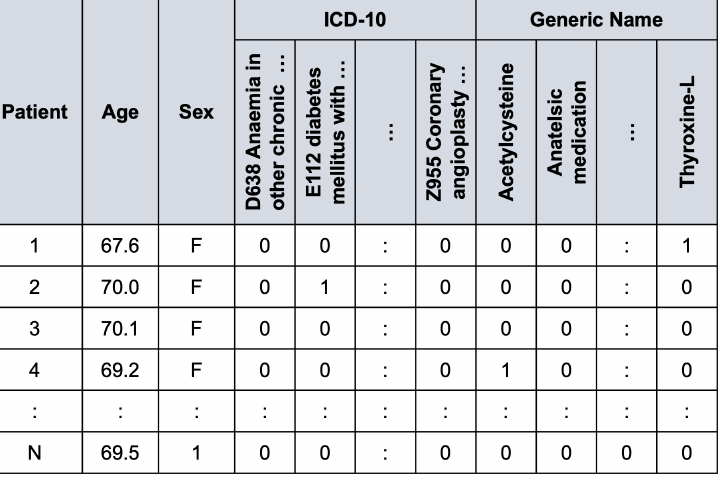
Figure 4. Example of the preprocessed data